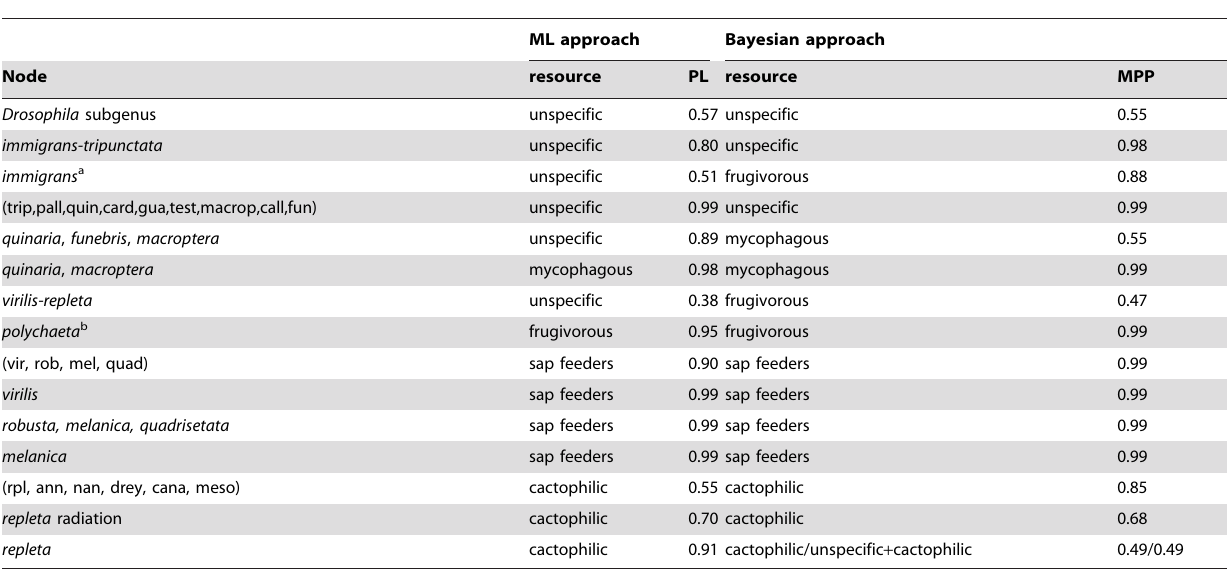
Table 3. Ancestral reconstruction of the ecological resource used obtained with Likelihood (ML) and Bayesian